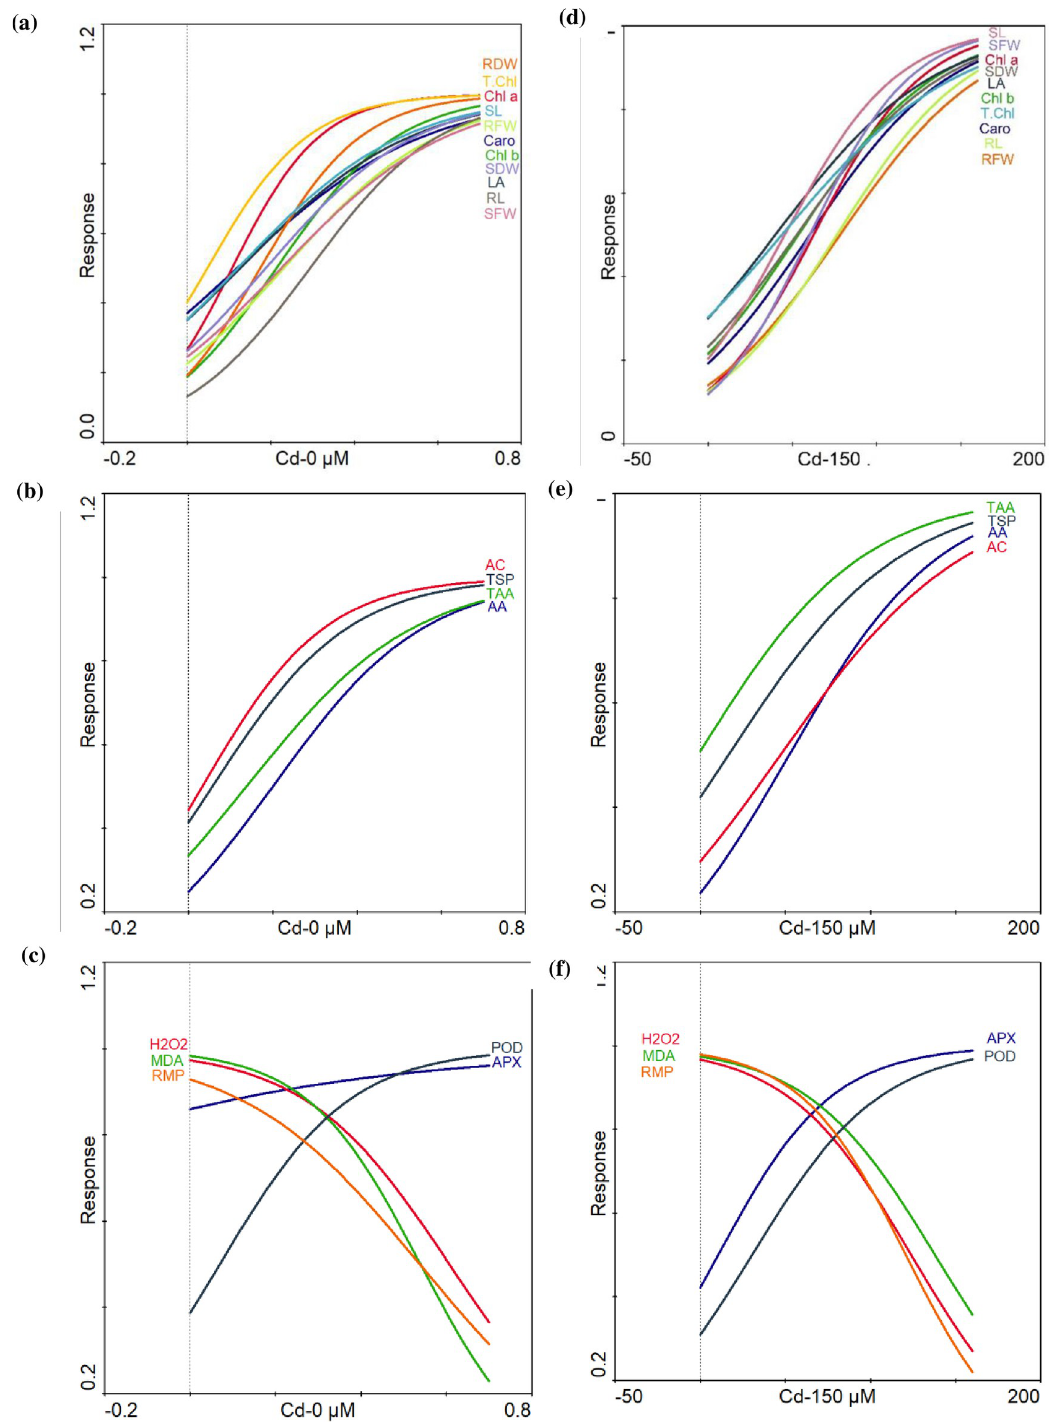
Fig 6. Generalized linear model showing response curve of traits under Cd and Ca treatments. Cd- 0 μ M stress: (a) growth and chlorophyll (b) organic osmolytes, ascorbic acid and anthocyanin contents (c) hydrogen peroxide, relative membrane permeability, lipid peroxidation and antioxidants. Cd- 150 μ M stress; (d) growth and chlorophyll (e) organic osmolytes, ascorbic acid and anthocyanin contents (f) hydrogen peroxide, relative membrane permeability, lipid peroxidation and antioxidants. Abbreviations are given at start of